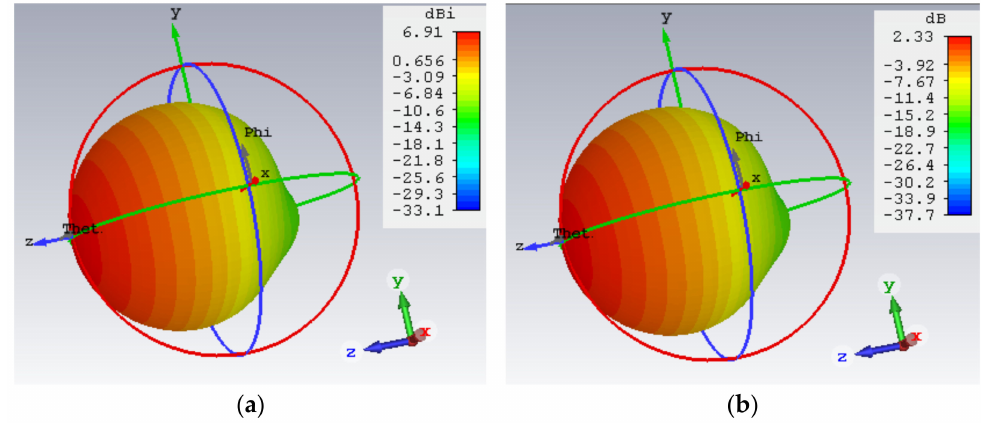
Figure 14. ( a ) Directivity and ( b ) gain ( right ) of patch antenna of 2.4 GHz with line transmission λ /4.